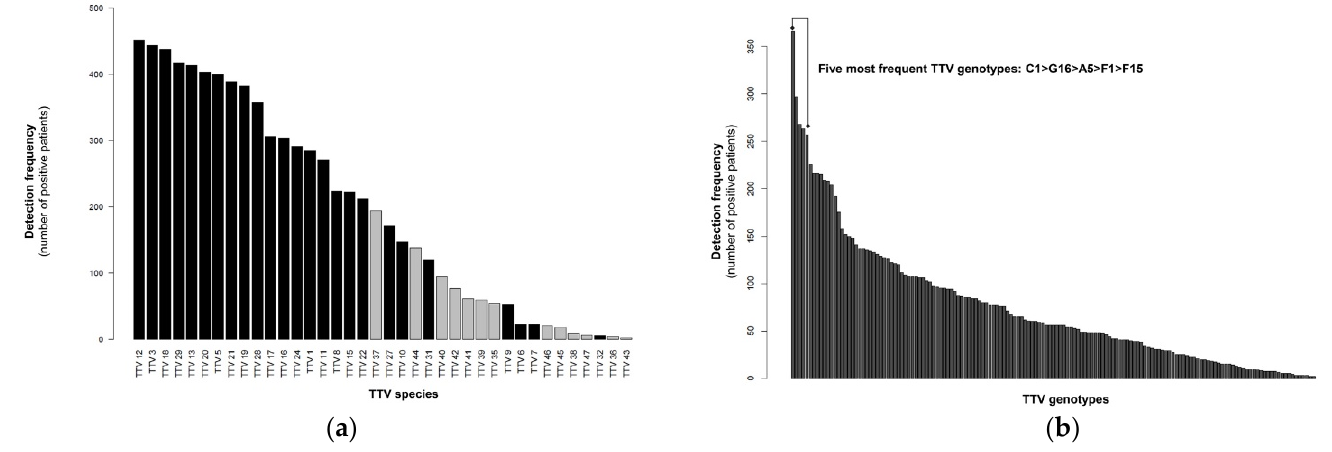
Figure 3. Frequency of each TTV species and genotype. ( a ) Barplot showing the number of positive patients for each TTV species detected by mNGS. The 25 TTV species known to infect humans as well as the 13 additional species reported in this study are represented by black and grey bars, respectively; ( b ) Barplot showing the number of positive patients for each TTV genotype detected by mNGS.